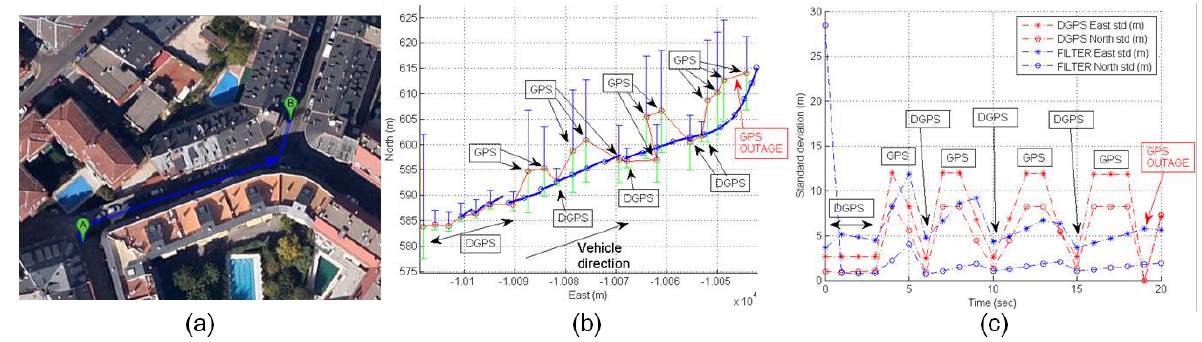
Figure 23. ( a ) Second rover trajectory within complex urban canyon. ( b ) DGPS and GPS solutions (red) and UKF filter solution (blue). ( c ) Time-domain standard deviation evolutions (DGPS and filter).